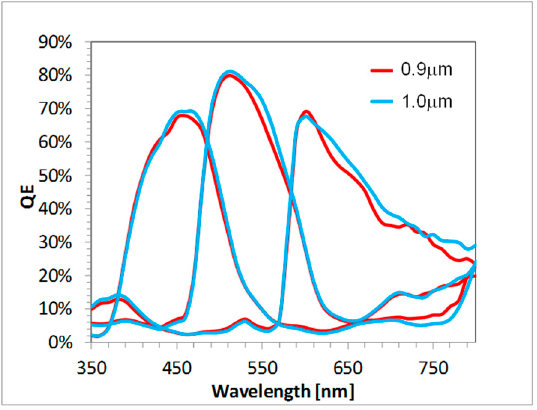
Figure 6. The QE from 1 µm and 0.9 µm pixel products, both using the Gen2 BSI-stacking technology.